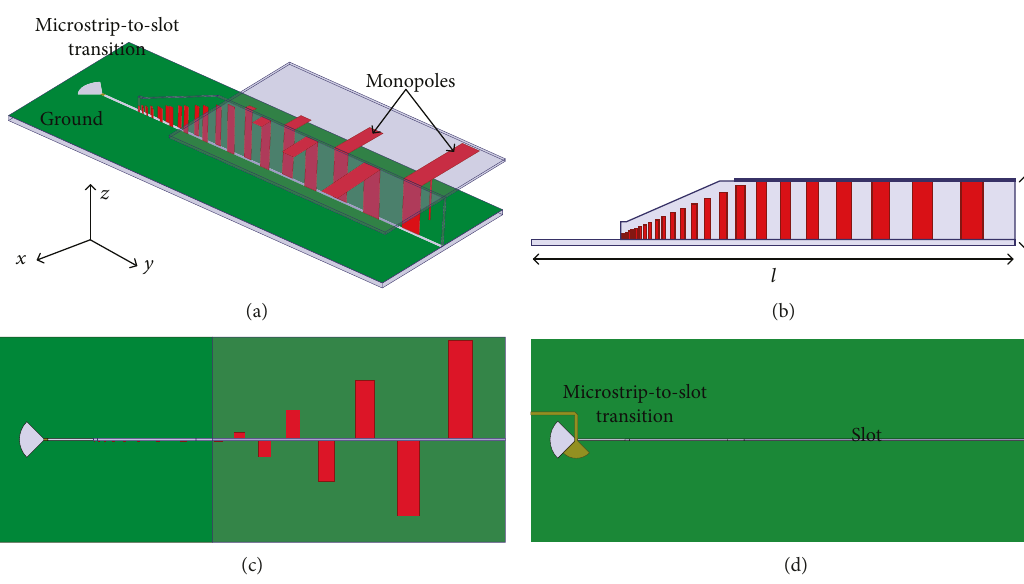
Figure 1: (a) Three-dimensional antenna geometry: (b) side view, (c) top view, and (d) bottom